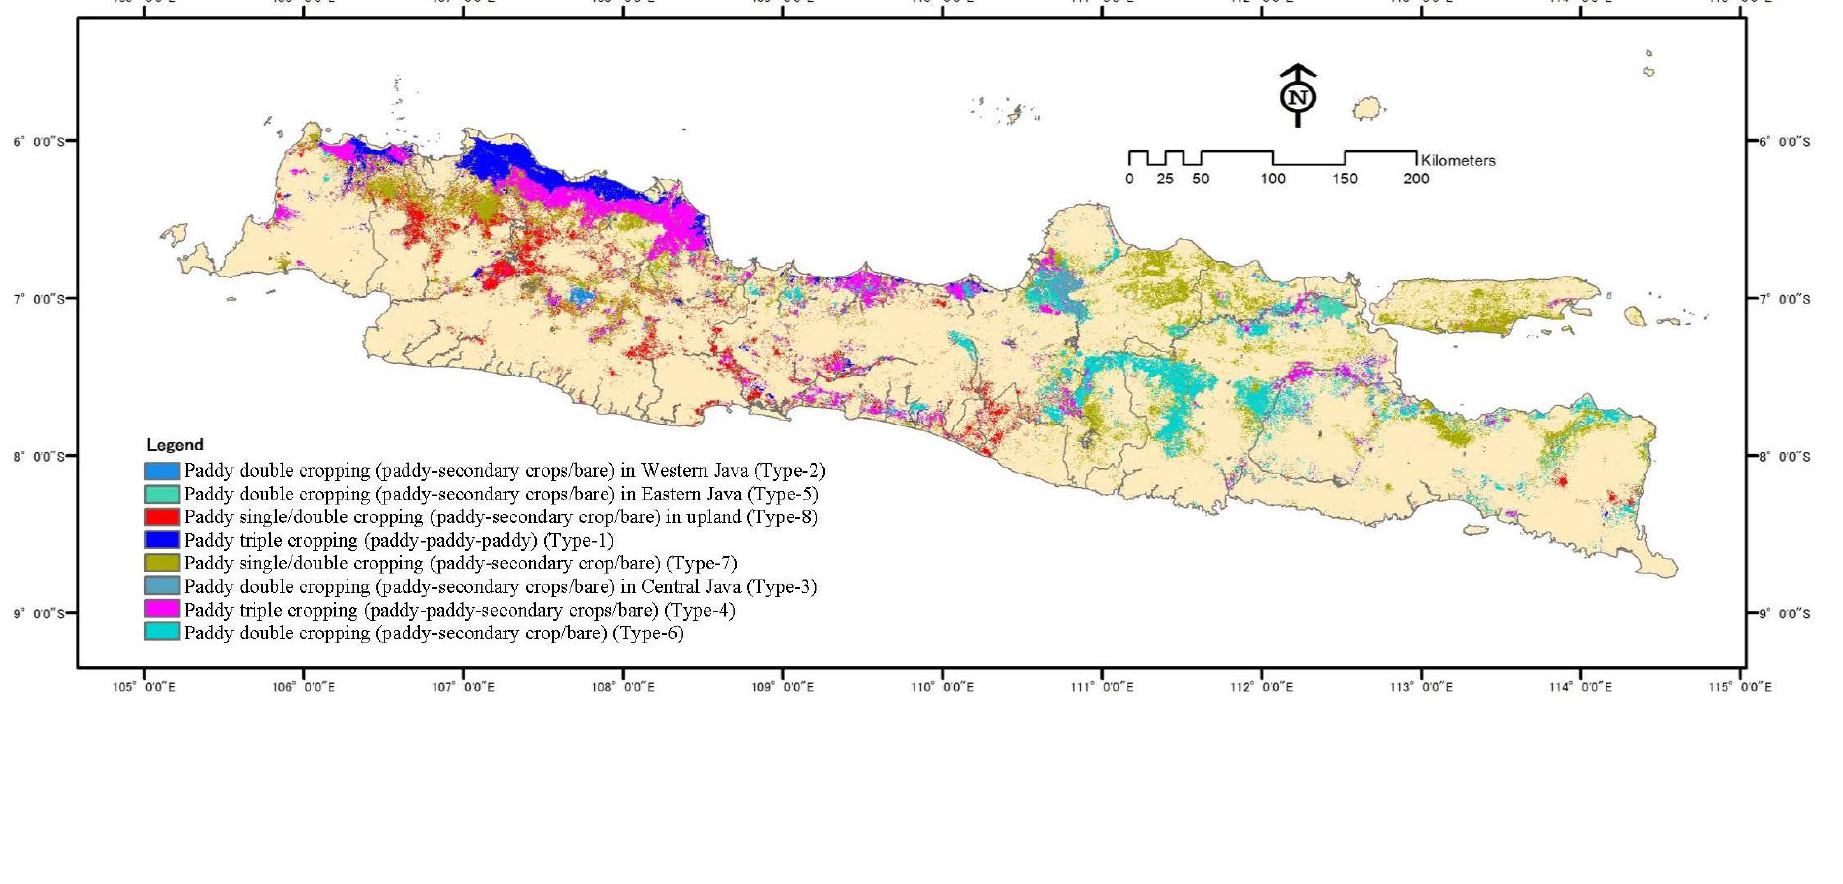
Figure 7. Distribution of paddy-rice fields differentiated by their annual cropping